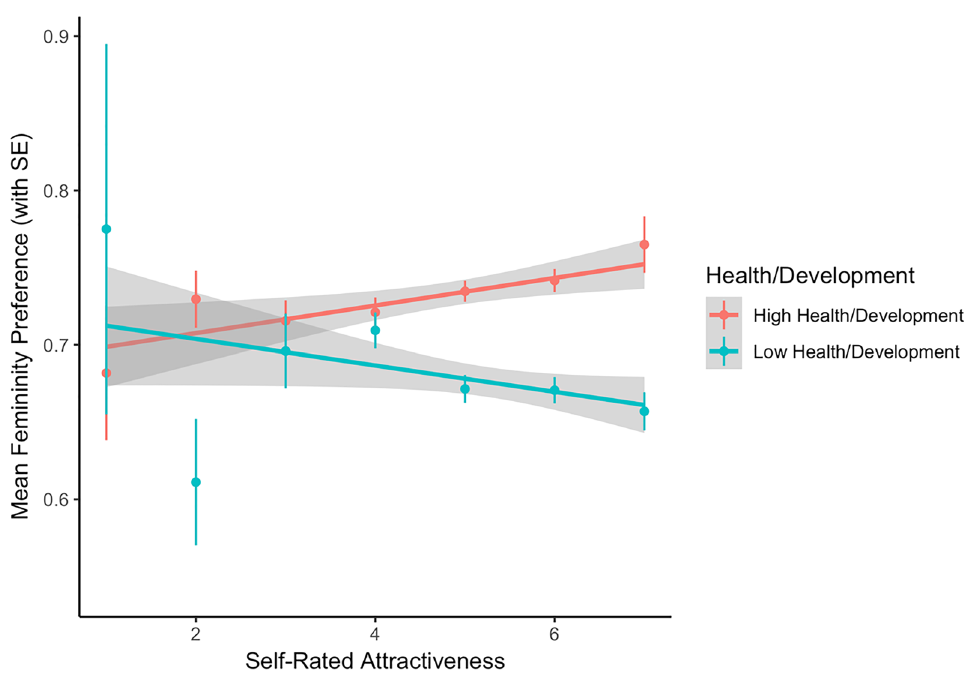
Figure 5. The significant interaction between the effects of scores on the health/development factor and men’s self-rated